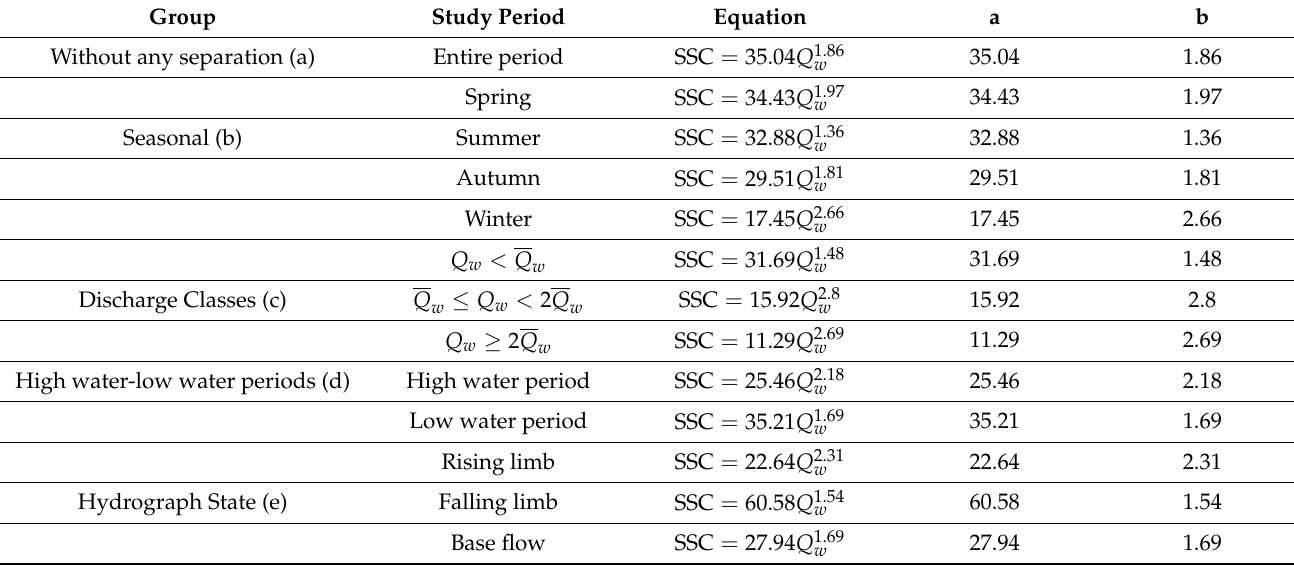
Table 4. Coefficients of the SRC equations in each of the data separation methods for the training dataset.